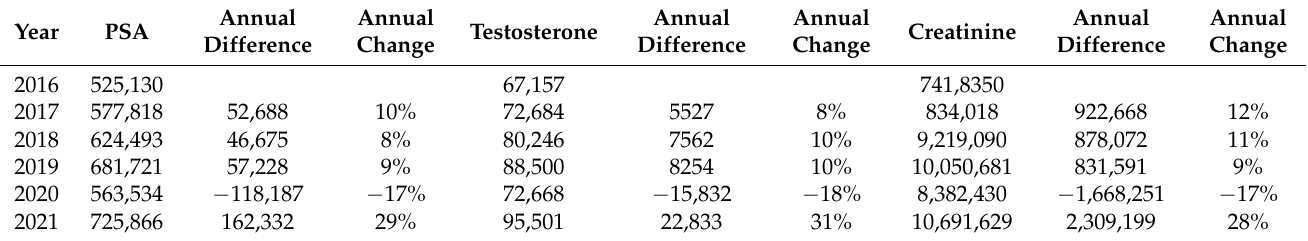
Table 5. Number of PSA, testosterone and creatine tests